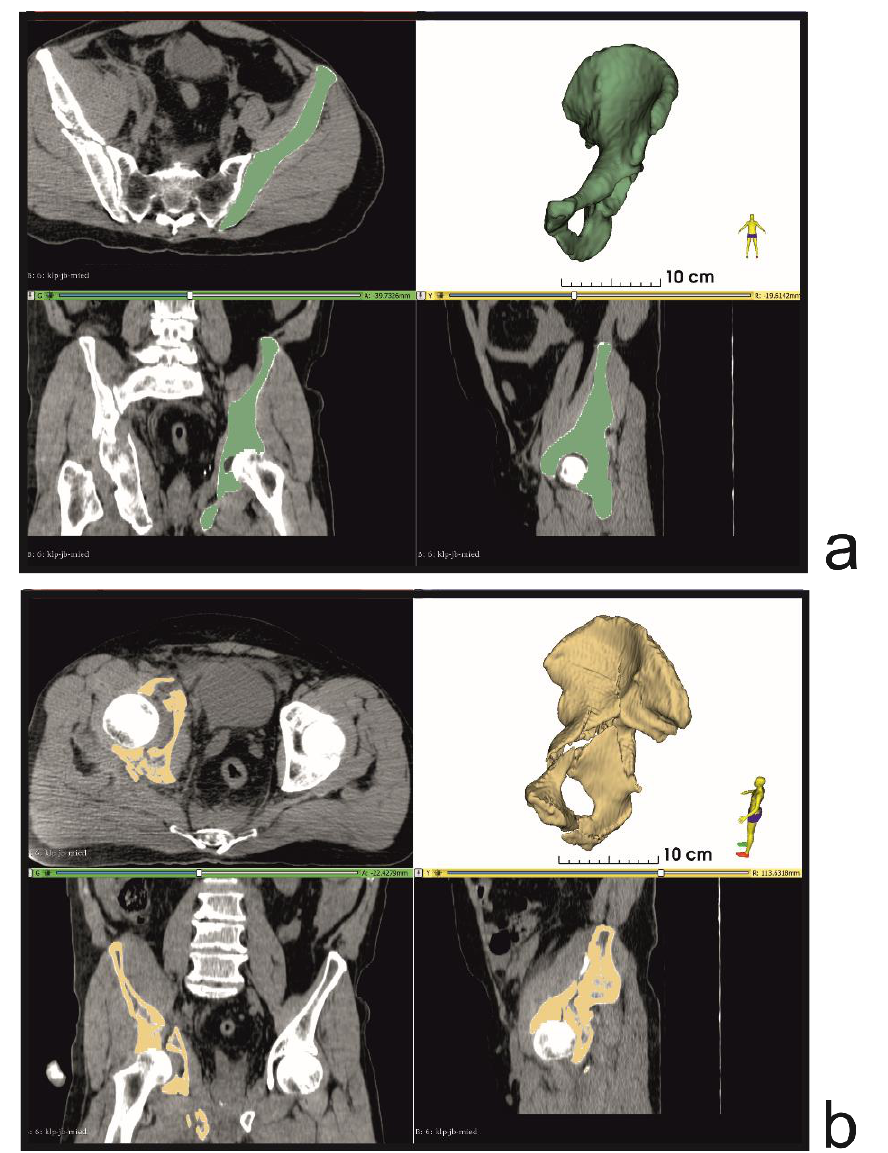
Figure 2. Bone tissue segmentation and virtual 3D models ( a ) uninjured contralateral side ( b ) injured side of the pelvis.